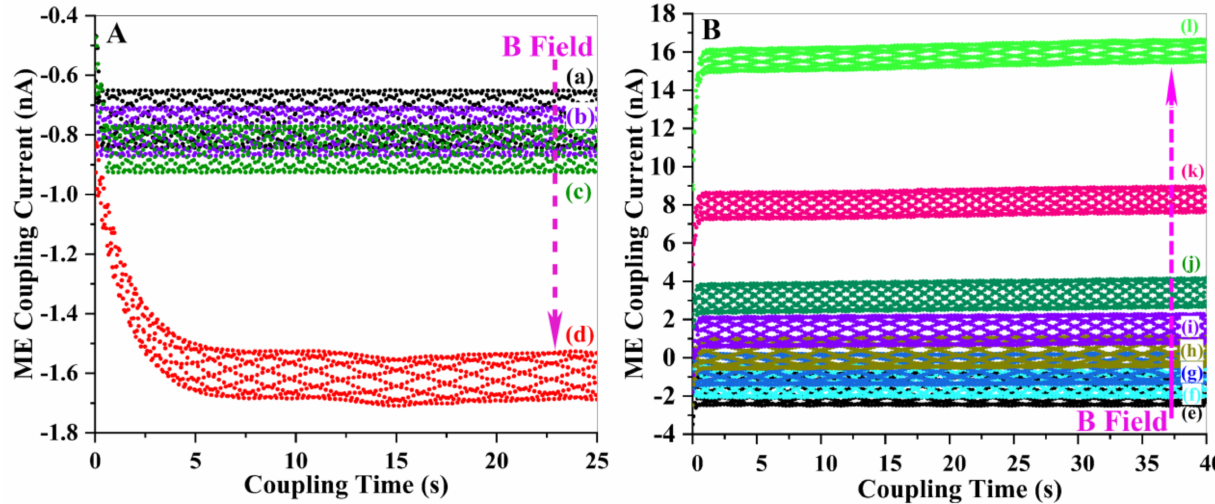
Figure 9. The shift of spin current waves with the external magnetic field in La 0.5 Sr 0.5 Fe 12 O 19 ceramics; ( A ): (a) 50 m T, (b) 100 m T, (c) 150 m T, (d) 200 m T, ( B ): (e) 400 m T, (f) 500 m T, (g) 600 m